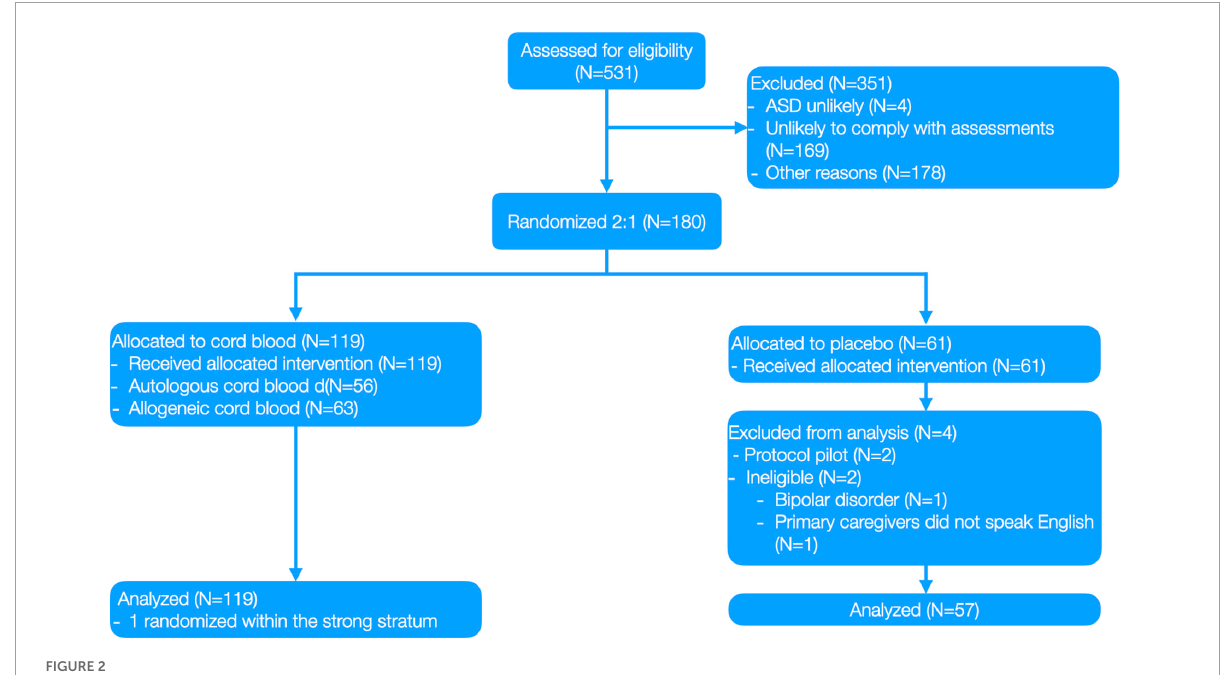
FIGURE2 Clinical trial CONSORT diagram from Dawson, Sun